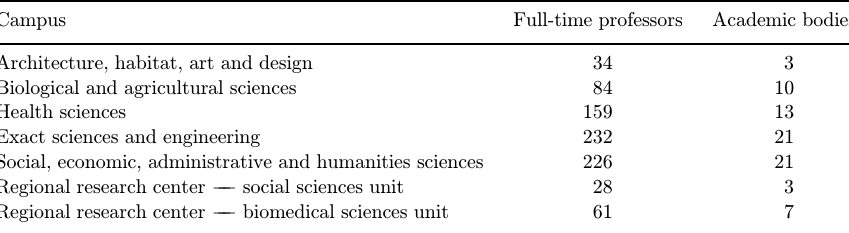
Table 1. Full-time professors and academic bodies by